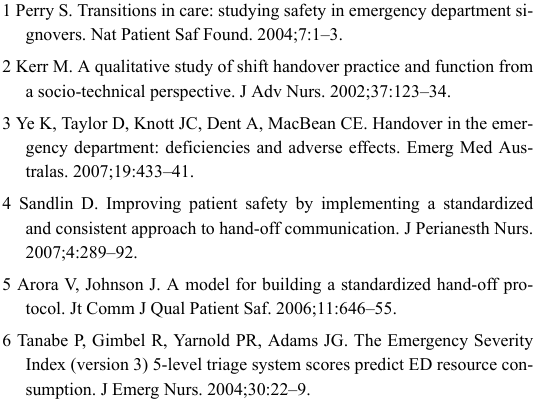
Table 2 Consequences of missing or wrong information given in handovers as judged by senior ED physician in the post-handover survey. Consequences of wrong or missing information (n = 996) pre post p Type of consequence n % n % Repetition of assessment 26 More time necessary Delay of care Confusion